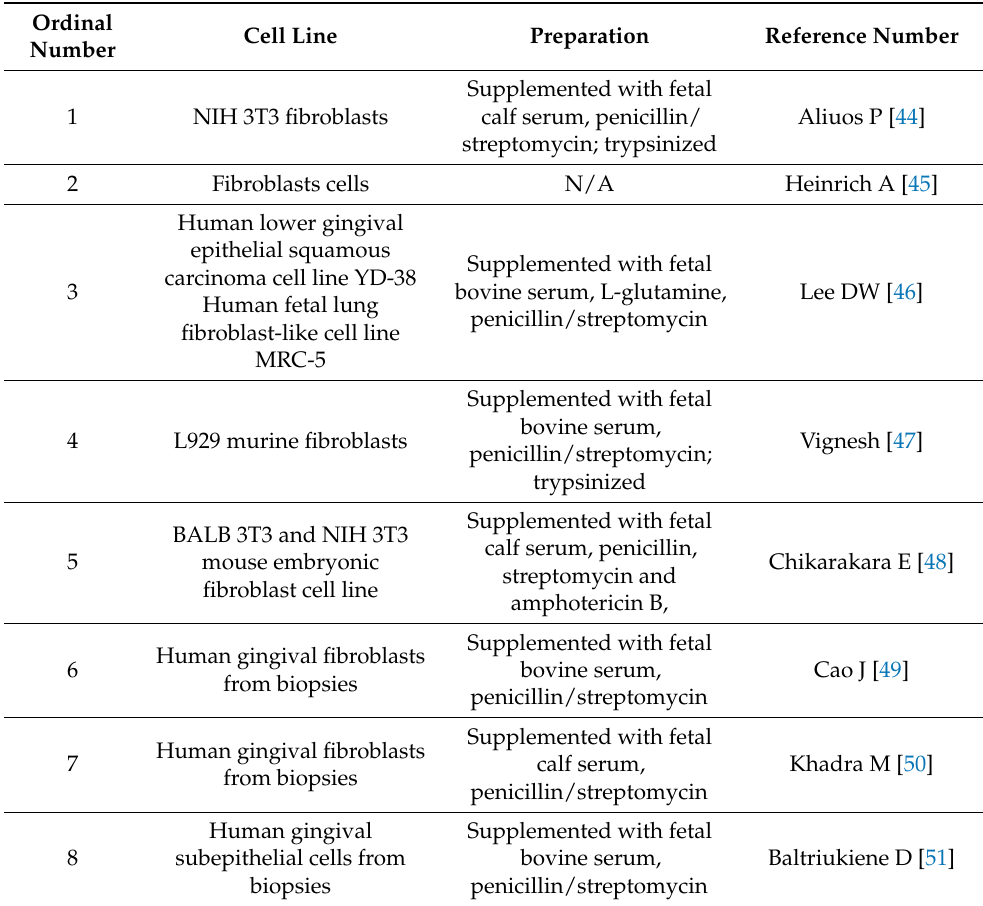
Table 3. Characteristics of cells used in the